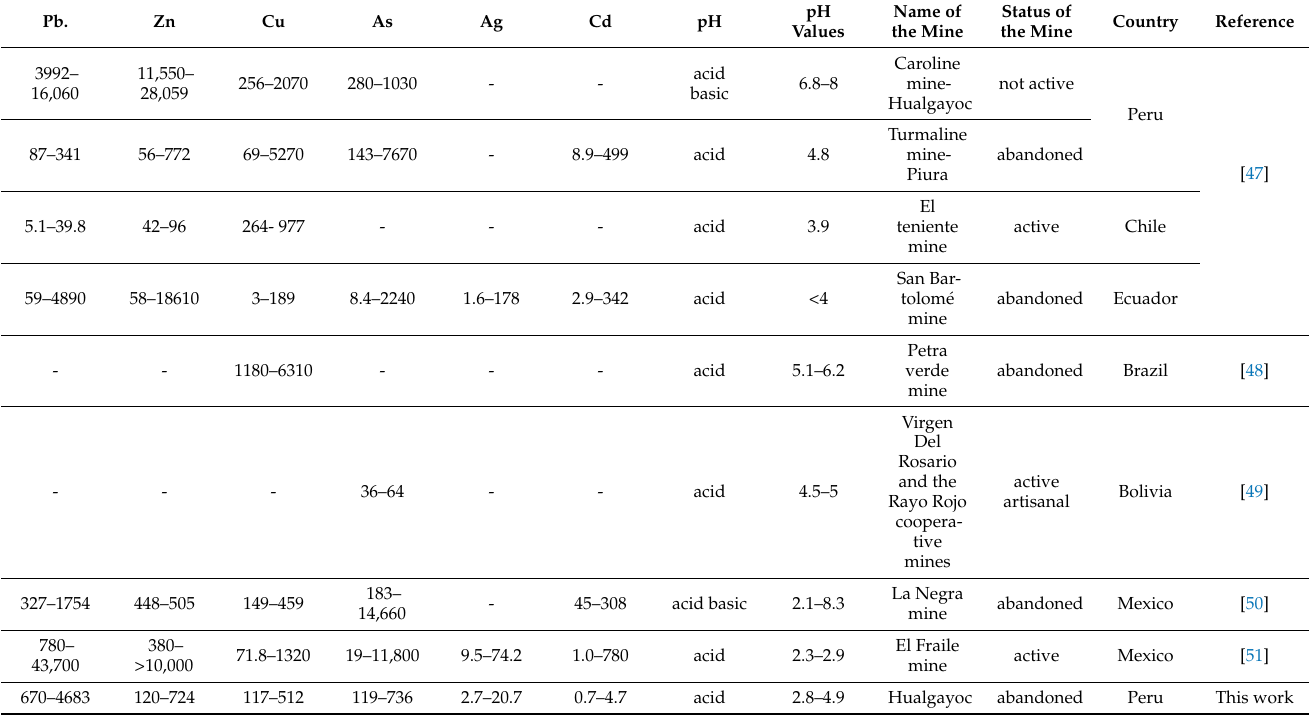
Table 2. Concentrations of Pb, Zn, Cu, As, Ag, and Cd (mg kg − 1 ) reported in the literature for soil of mining sites in Peru and other South American